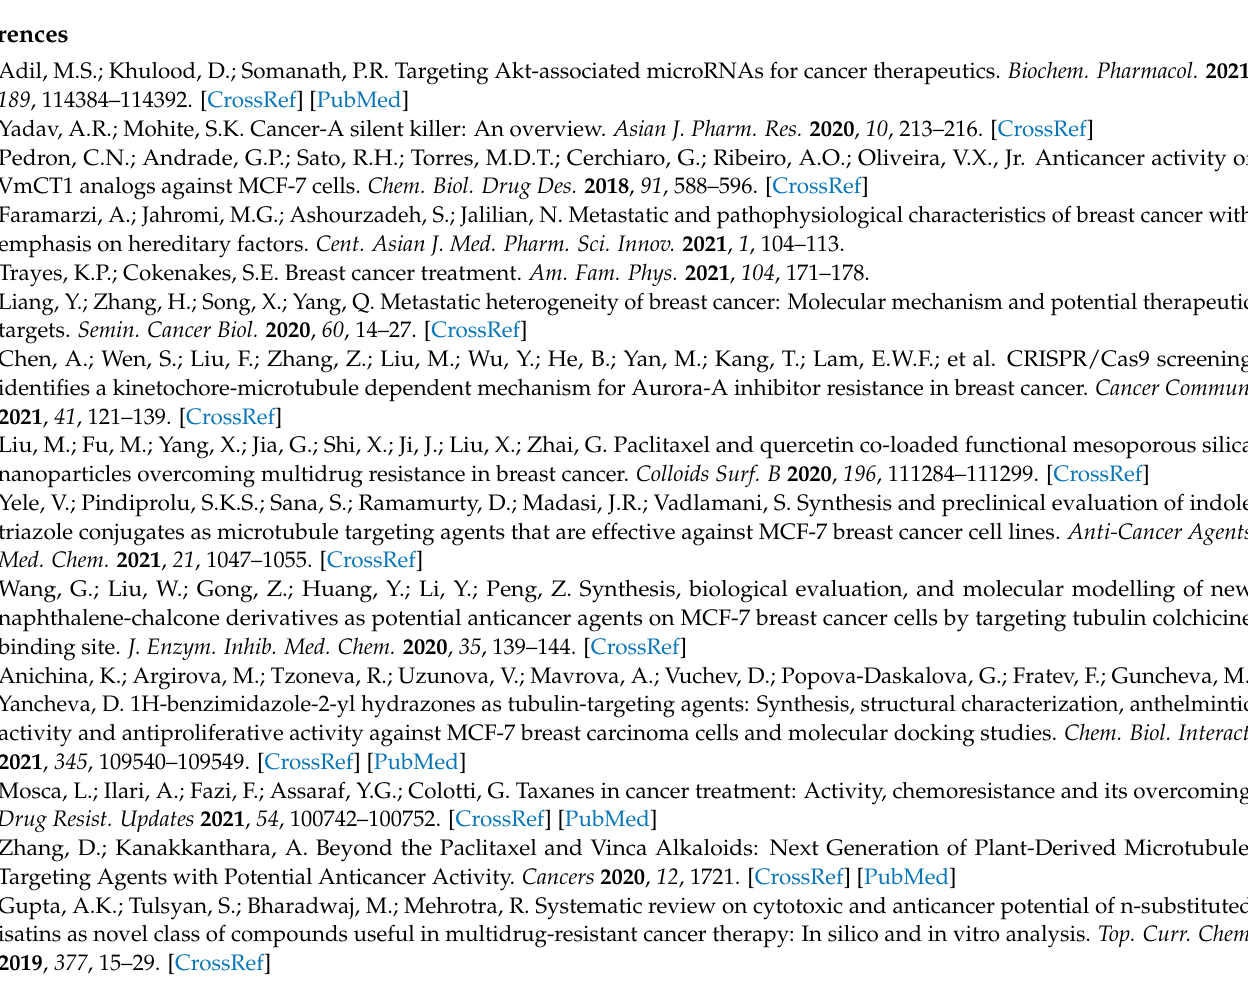
Figure S6: 1 H-NMR spectrum of compound 3b ; Figure S7: 13 C-NMR spectrum of compound 3b ; Figure S8: 1 H-NMR spectrum of compound 4 ; Figure S9: 13 C-NMR spectrum of compound 4 ; Figure S10: 1 H-NMR spectrum of compound 5a ; Figure S11: 13 C-NMR spectrum of compound 5a ; Figure S12: 1 H-NMR spectrum of compound 5b ; Figure S13: 13 C-NMR spectrum of compound 5b ; Figure S14: 1 H-NMR spectrum of compound 6 ; Figure S15: 13 C-NMR spectrum of compound 6 ; Figure S16: 1 H-NMR spectrum of compound 7 ; Figure S17: 13 C-NMR spectrum of compound 7